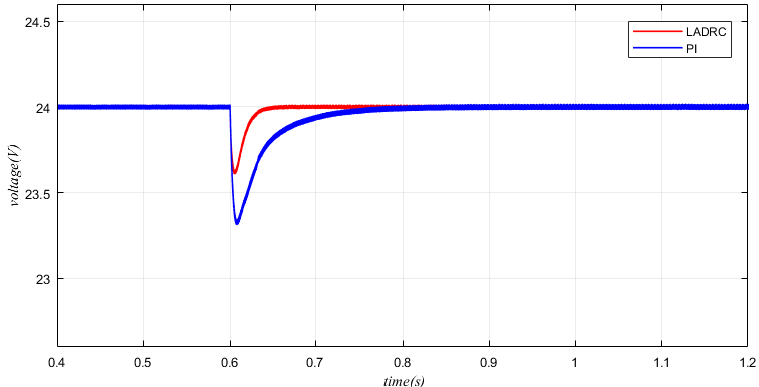
Figure 8. Output voltage responses in Case 1.